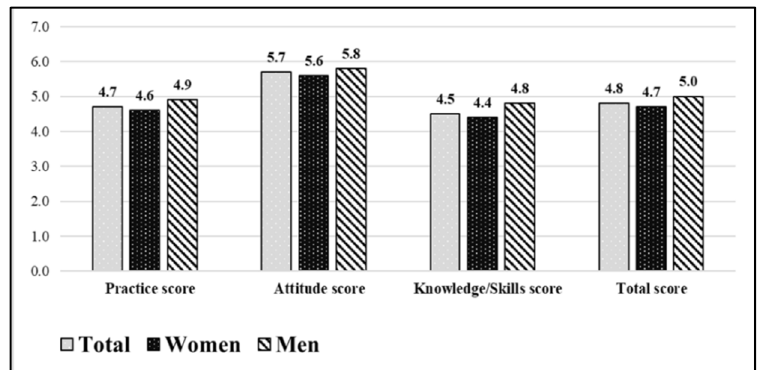
Figure 1. EBPQ-19 scores and levels.